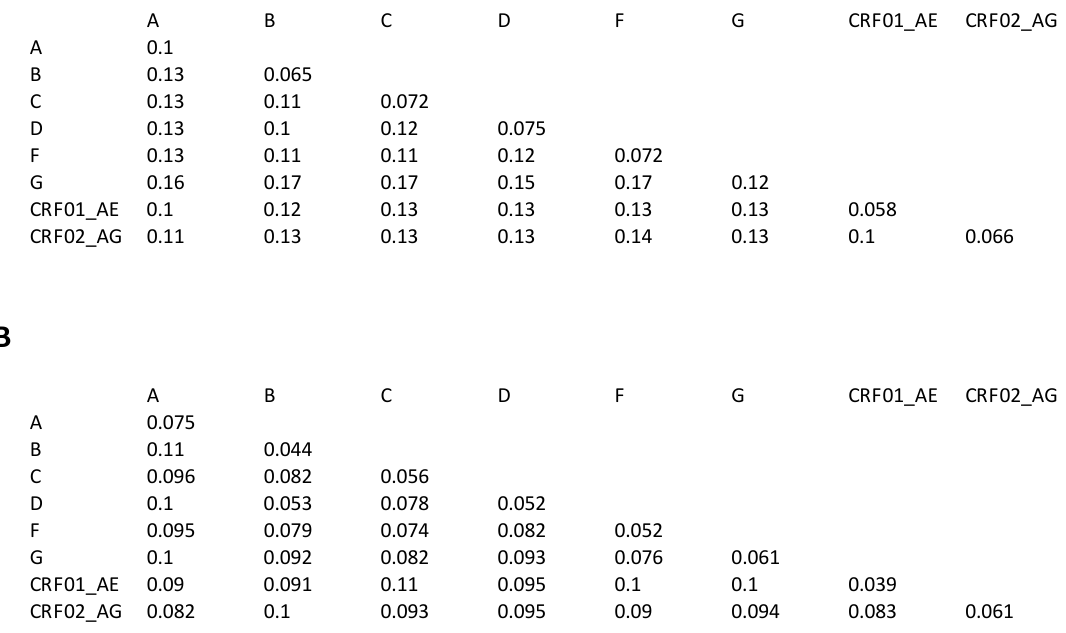
Figure 2. The median intra-subtype and inter-subtype nucleotide ( A ) and amino acid ( B ) distance between capsid sequences belonging to eight major